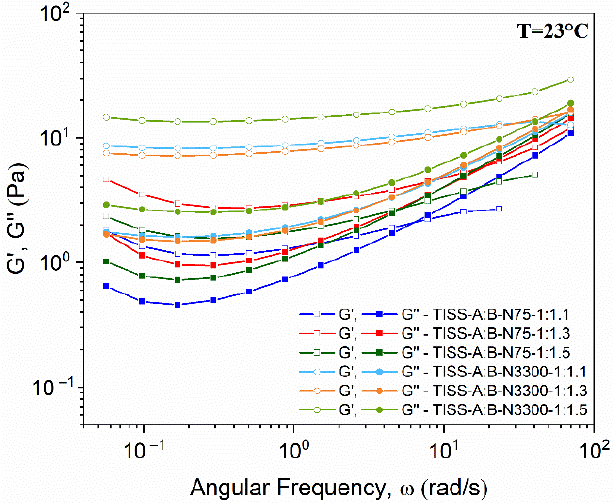
Figure 9. Oscillatory tests: frequency dependency of dynamic moduli for TISS paints, prepared with fluoropolymer binder L200 and various concentrations of two catalysts Desmodur N75 and Desmodur N3300, respectively.